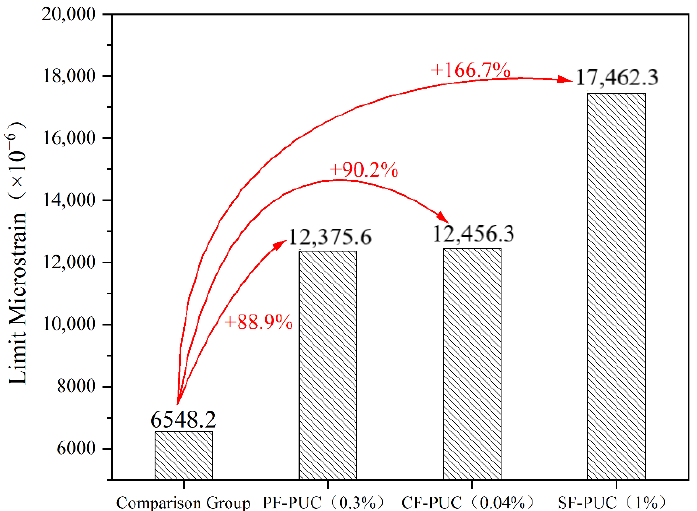
Figure 5. Ultimate micro-strain at optimal volume doping ratio (normal temperature 20 °C).